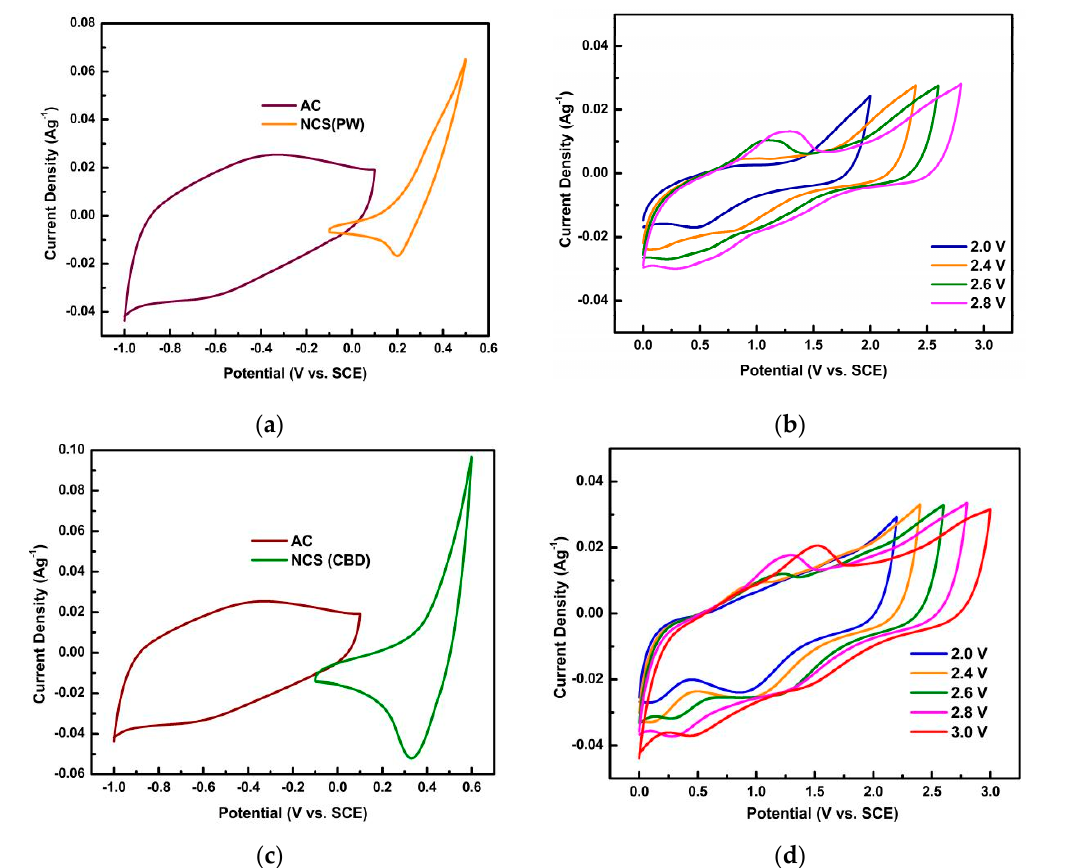
Figure 5. Electrochemical properties of NiCo 2 S 4 /activated carbon hybrid supercapacitors: ( a ) the total potential window of 1.5 V for NCS(PW)/Ni electrodes; ( b ) the CV of the NCS(PW)/Ni HSC; ( c ) the total potential window of 1.6 V for NCS(CBD)/Ni electrodes; ( d ) the CV of the NCS(CBD)/Ni HSC.